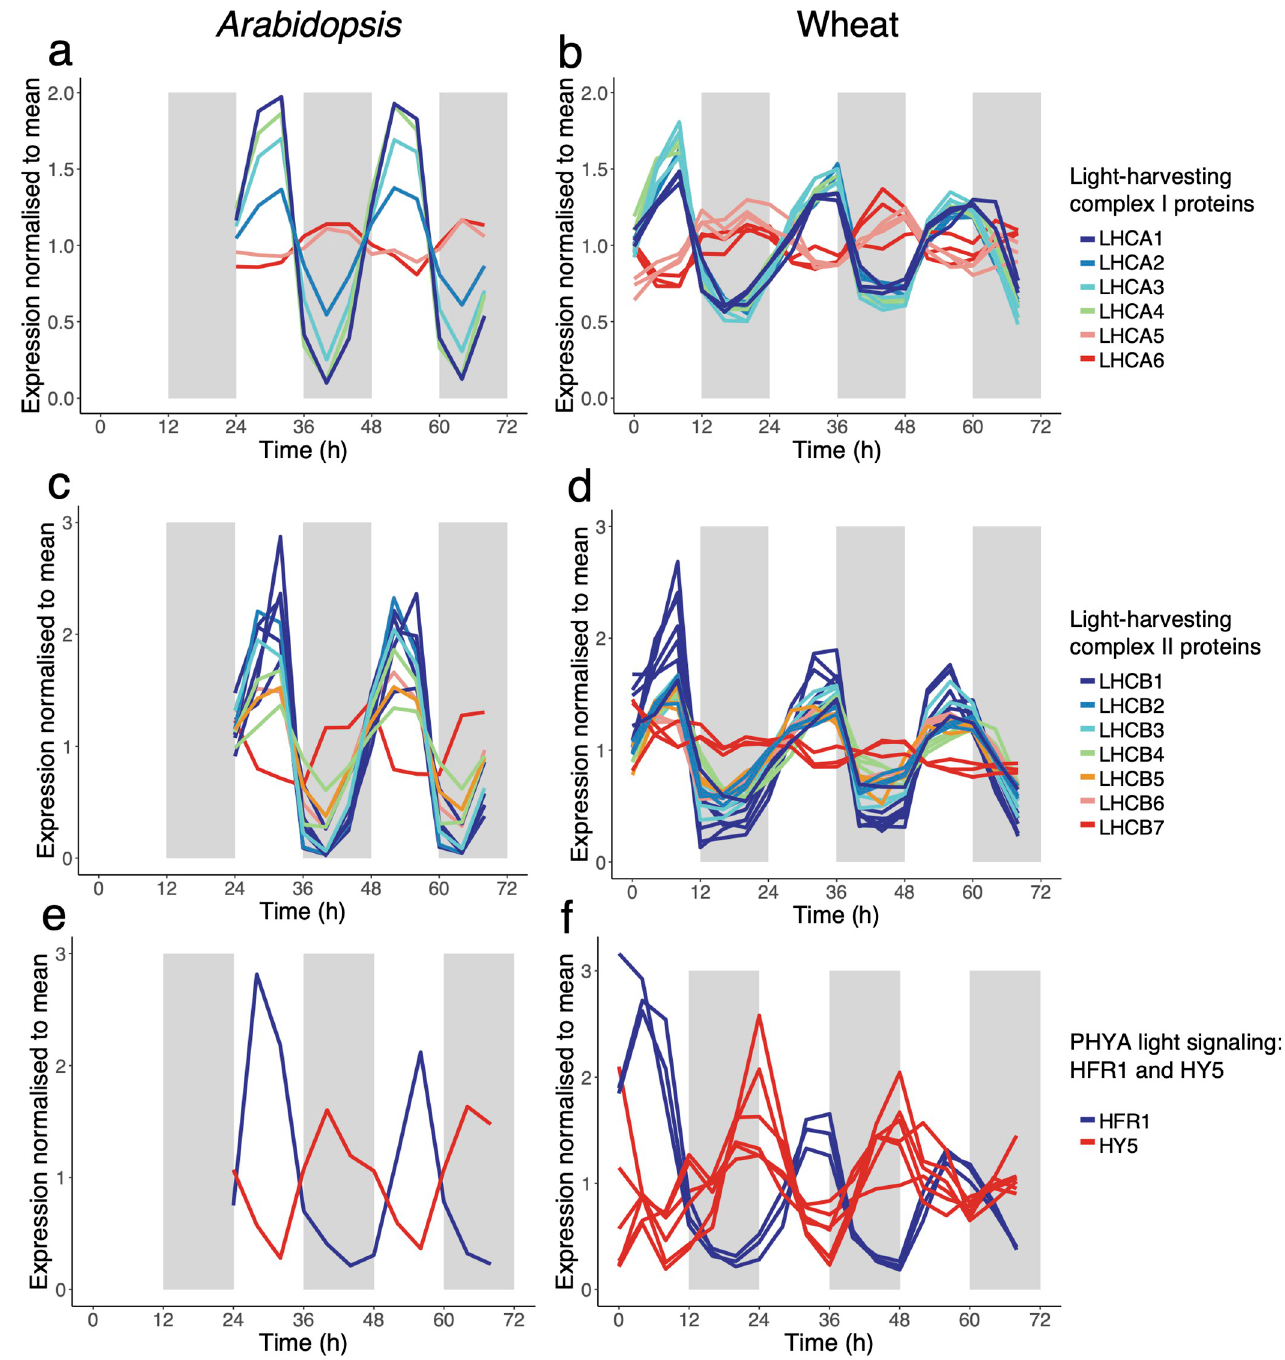
Fig 4. Conserved expression of circadian regulated transcripts involved in photosynthesis and light signalling. Examples of transcripts encoding light- harvesting chlorophyll a/b-binding (LHC) proteins associated with photosystem I ( LHCA1-6 ) in Arabidopsis (a) and wheat (b) and photosystem II in Arabidopsis (c) and wheat (d). Two regulators of photomorphogenesis acting downstream of PHYA signalling, LONG HYPOCOTYL 5 (HY5) and LONG HYPOCOTYL IN FAR-RED 1 (HFR1) are circadian regulated and show antiphase expression patterns in Arabidopsis (e) and wheat (f). Transcripts are measured in TPM and are mean normalised to aid the comparison of phase synchrony. Gene IDs of transcripts shown are in S10 Table. (Data_Fig 4a-f in S1